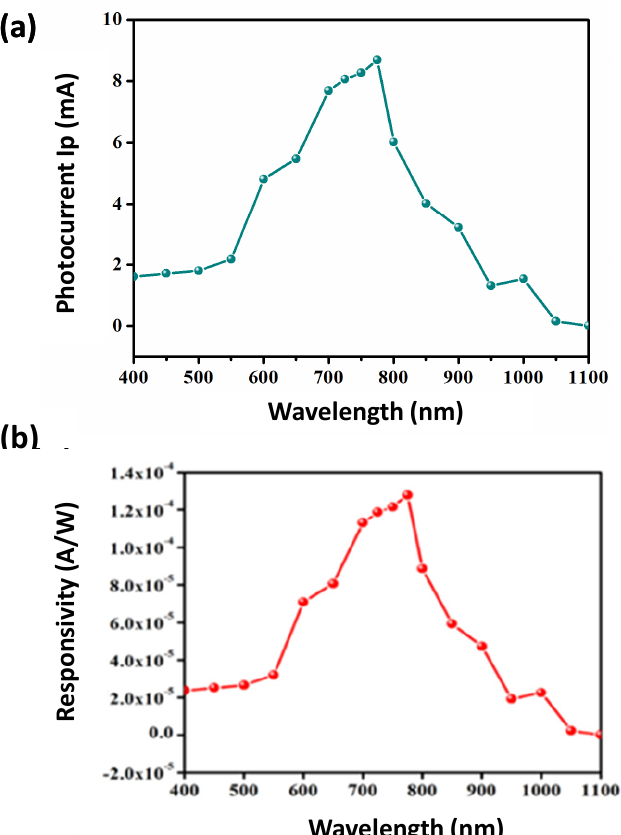
Figure 2. ( a ) The I p was measured as a function of λ over the 400 to 1100 nm spectral range for the 2DP film photoabsorber where the peak in I p occurring at ~775 nm was consistent with the peak position of the PL emission spectrum for our n = 4 , 2DP formulation. ( b ) Responsivity R as a function of λ over the same spectral range, and again, the highest R coincided with the PL peak emission observed in our 2DP photoabsorber. The laser power used was ~200 μ W and the laser spot size of the fiber optic cable irradiating our device defined an active area of ~5 μ m 2 .